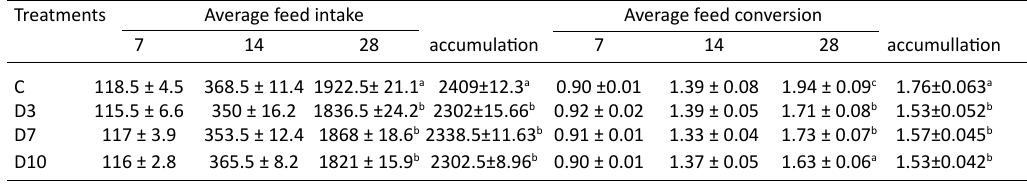
Table 5. Effect of microsafe spraying on the average feed intake and feed conversion (g) of broiler chickens ± SE